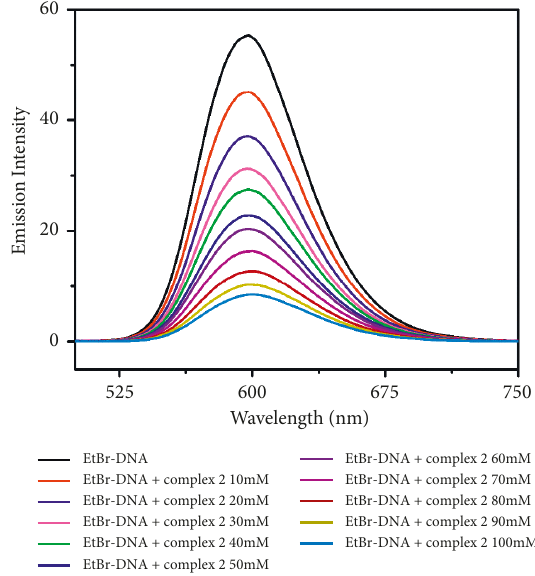
Figure 7: Fluorescence spectra of EtBr bound to DNA with in- creasing amounts of complex 2 (0–100 µ M).